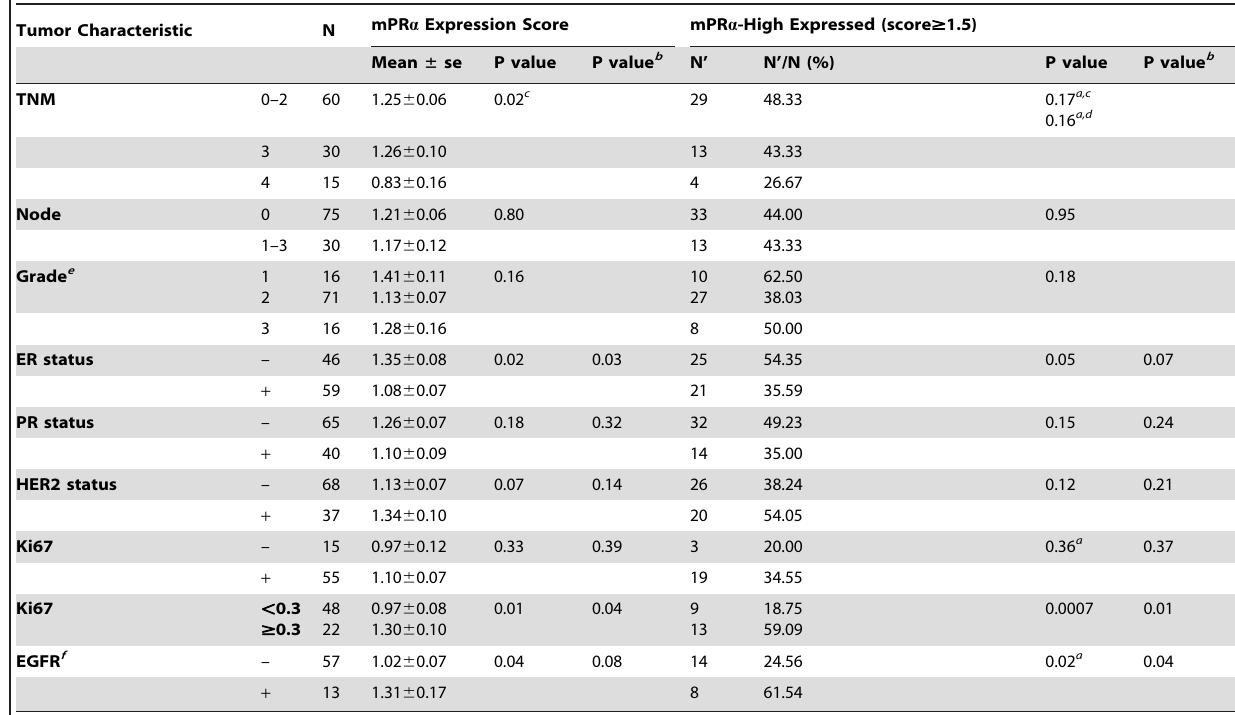
Table 2. Association of mPR a expression with various clinicopathological characteristics and pathway biomarkers.